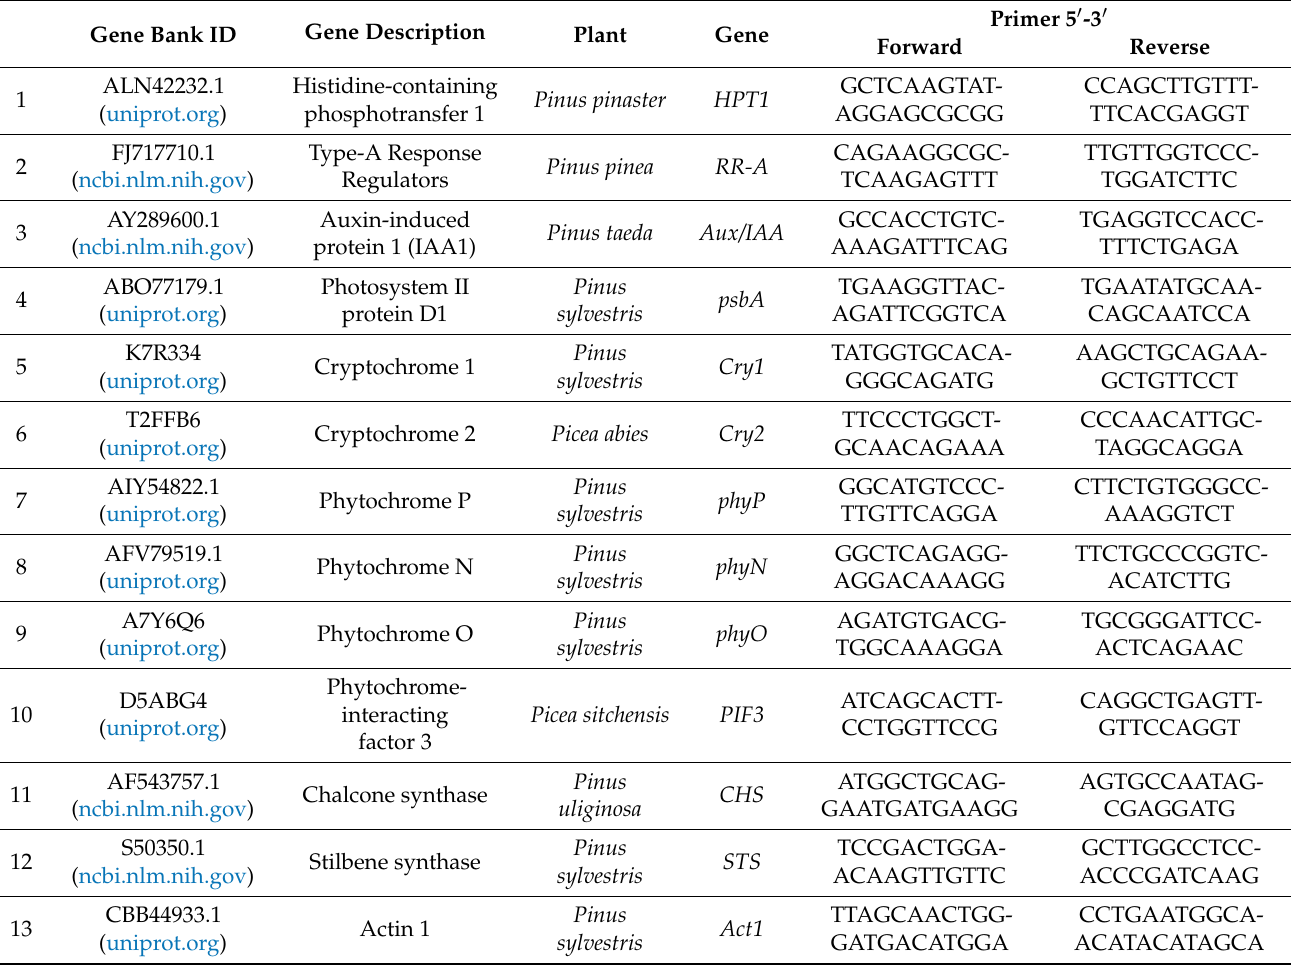
Table 1. The primers for qRT-PCR